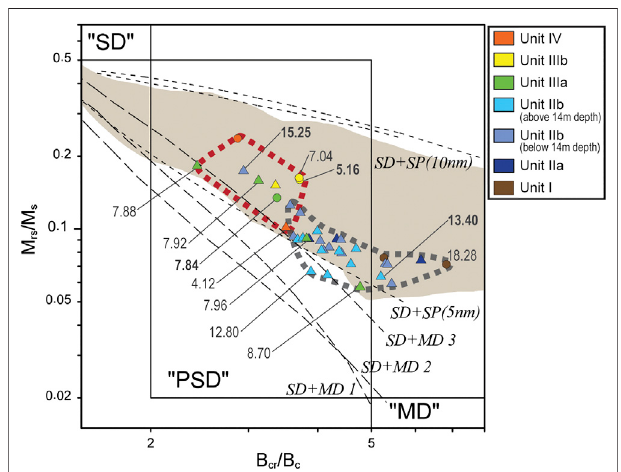
FIGURE 11 | Day plot of our YAR-4 core sediment data ( n (cid:1) 37) at different depths and sedimentary units. Circle and triangle symbols denotes the data measured from bulk and extract samples, respectively. Some data are labeled using the “ depth in core ” in meter, among which the data labeled in bold denote those where the associated FORC diagrams are providedin Figure10 .Single-domain(SD),pseudo-single-domain(PSD),and multi-domain (MD) boundaries, trend curves 1, 2, and 3 for SD + MD mixtures ofmagnetiteandtrendcurvesforSD+SPwith5-nmandSD+SPwith10-nm mixtures of magnetite were drawn by Dunlop (2002a), Dunlop (2002b). Color- shaded region represents a typical range for SD + SP mixtures of greigite indicated by Roberts et al. (2011). Division of the data into two groups by dashed enclosed lines was based on ranges of the B c , B cr , and M rs /M s values (see text for details).